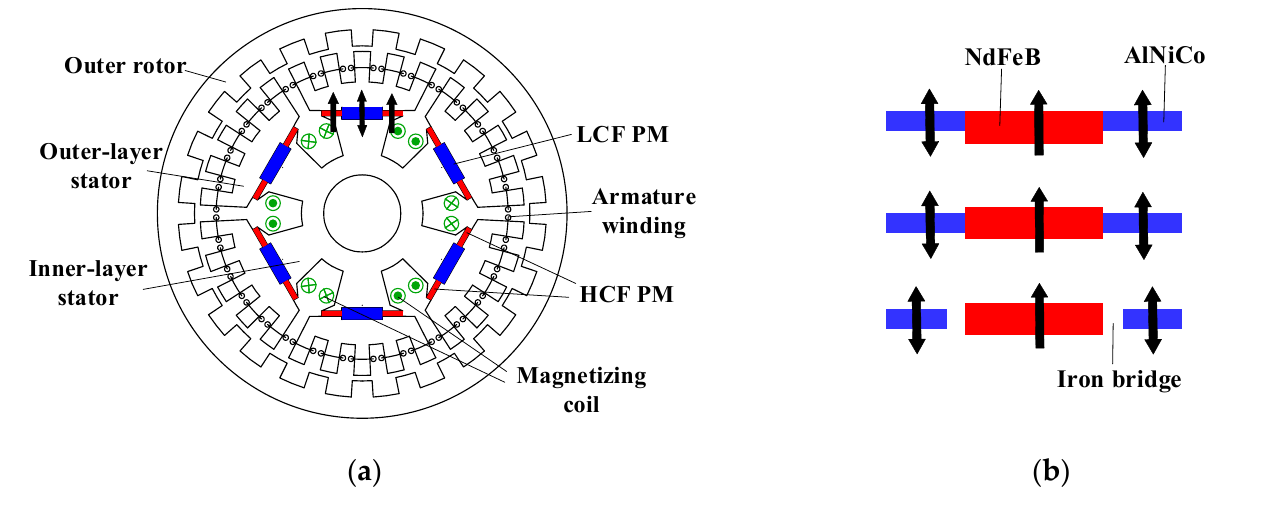
Figure 37. Hybrid PM VFM machine based doubly salient topology. ( a ) Machine topology [99]. ( b ) Design of PM locations and iron bridge [100].